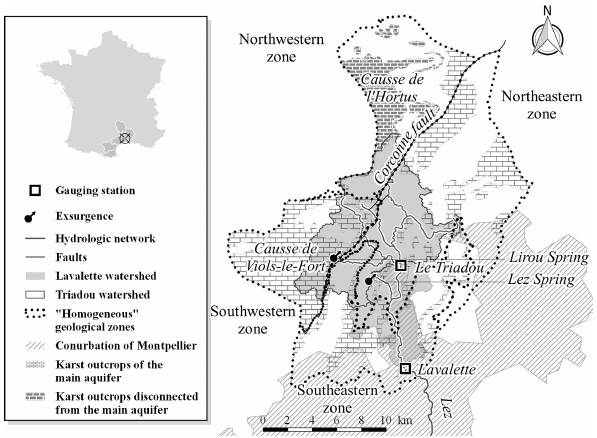
Figure 1. Map of the Lez hydrosystem with location of Le Triadou and Lavalette gauging station, Lez Spring and Lirou